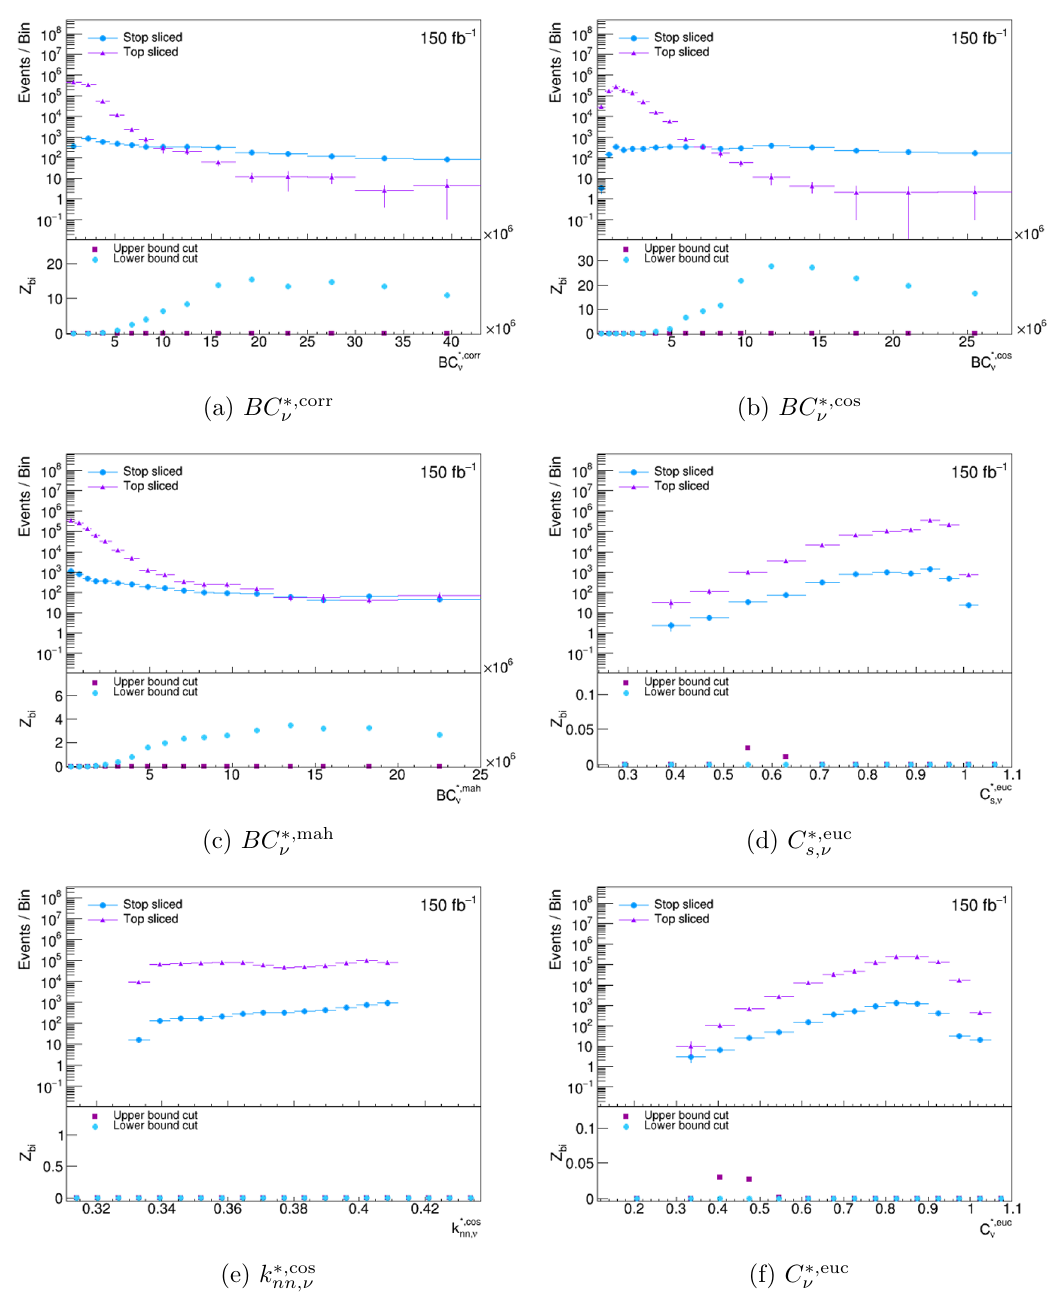
Figure 10. Event rates as functions of the network variables for the stop simplified model example that show the most difference between the signal and the background. Events in the overflow bin are not shown in the distribution but are included in the Z bi